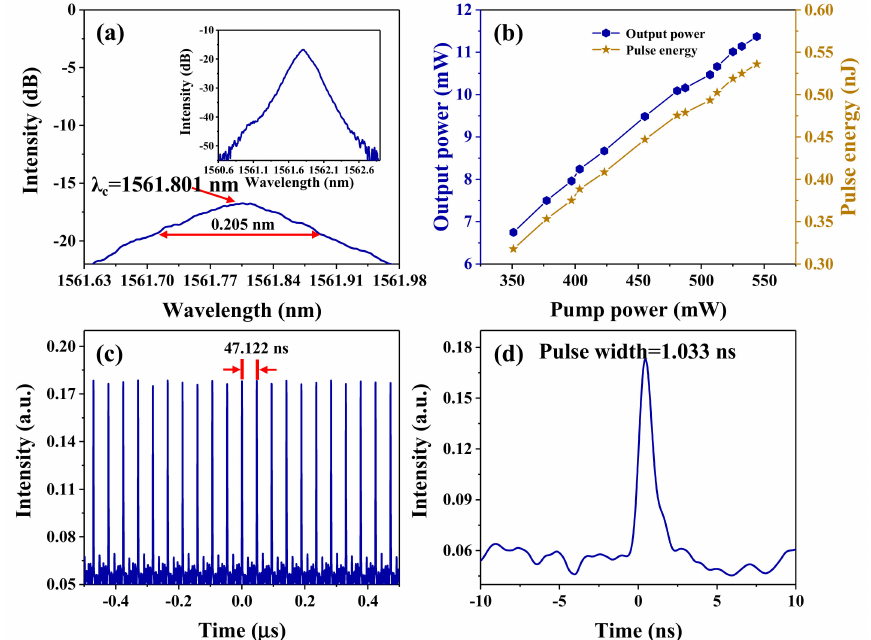
Figure 5. ( a ) The output optical spectrum (inset: the emission optical spectrum with a 2 nm span). ( b ) The output power and the single pulse energy versus the pump power. ( c ) The typical pulse train of the mode-locking operation. ( d ) The zoomed-in monopulse profile of the mode-locking operation.